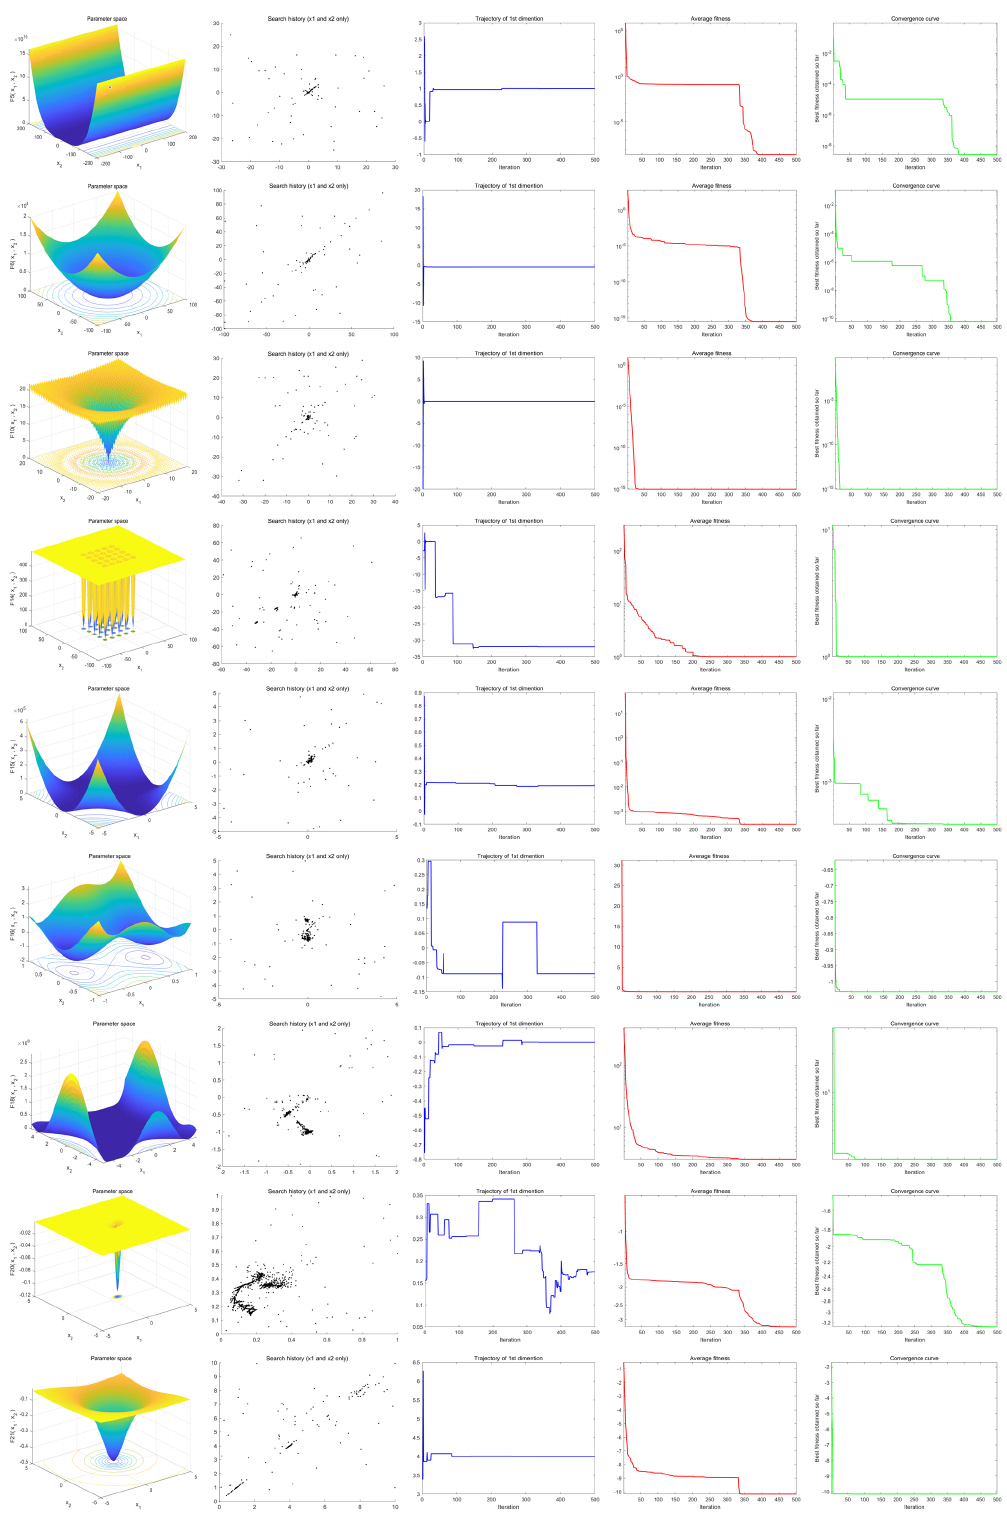
Figure 4. Qualitative results of